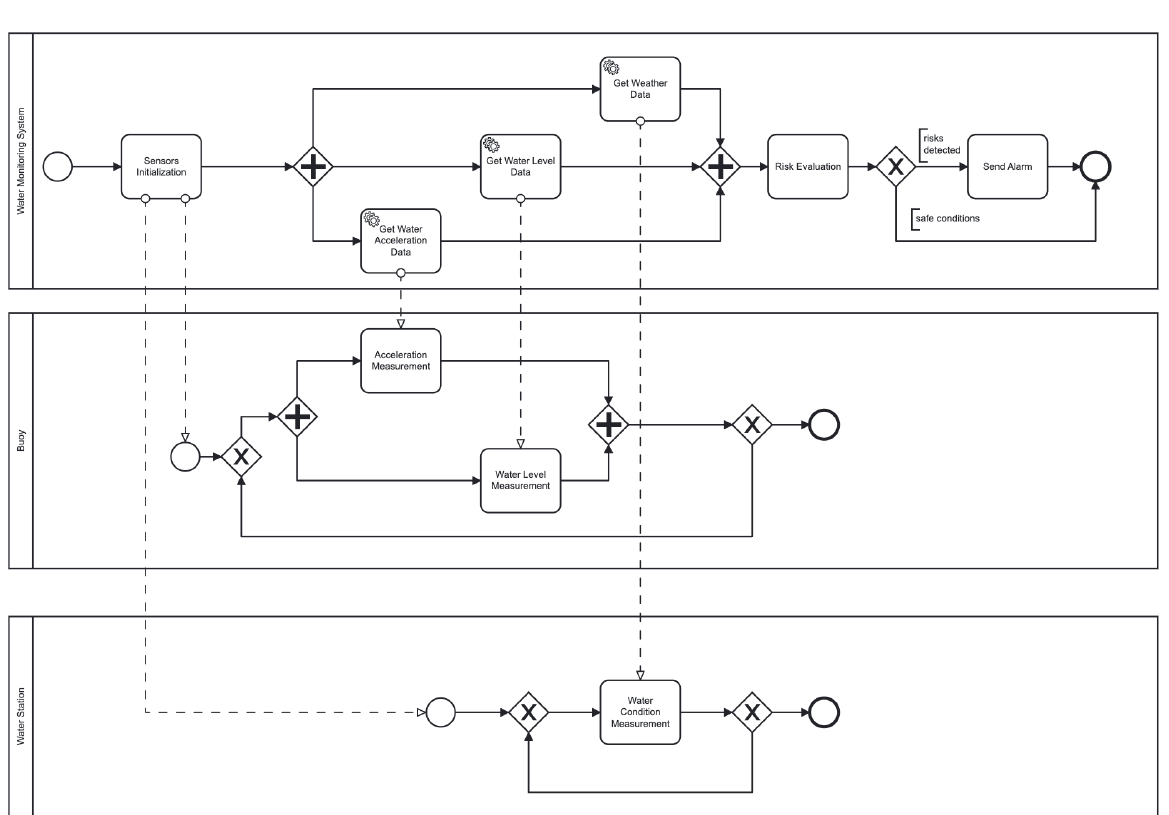
Figure 10. BPMN Model for the Water Alert System.